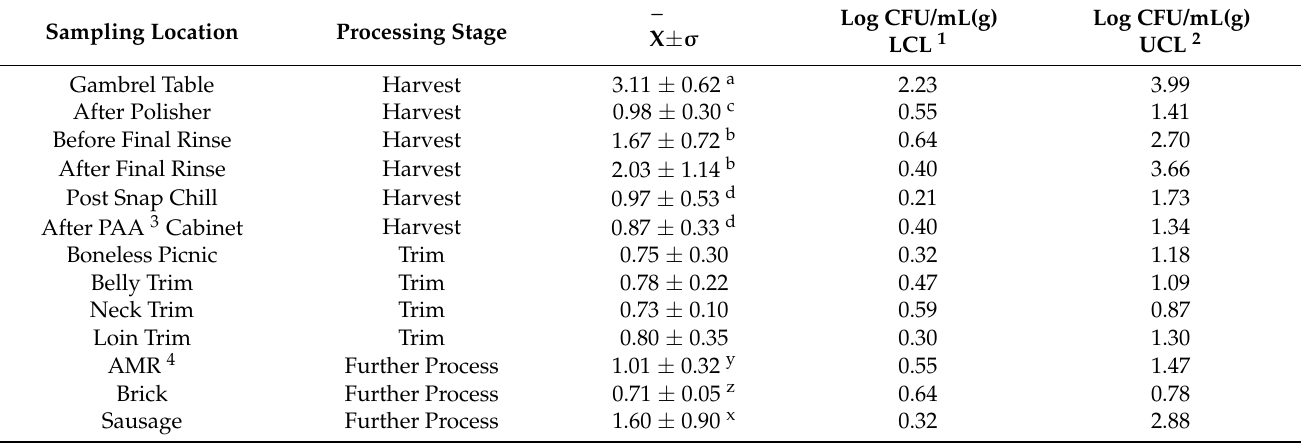
Table 3. Statistical process control parameters for generic E. coli (EC) counts calculated at each sam- pling location ( n = 5 samples/location) collected during 10 weeks throughout the pork processing